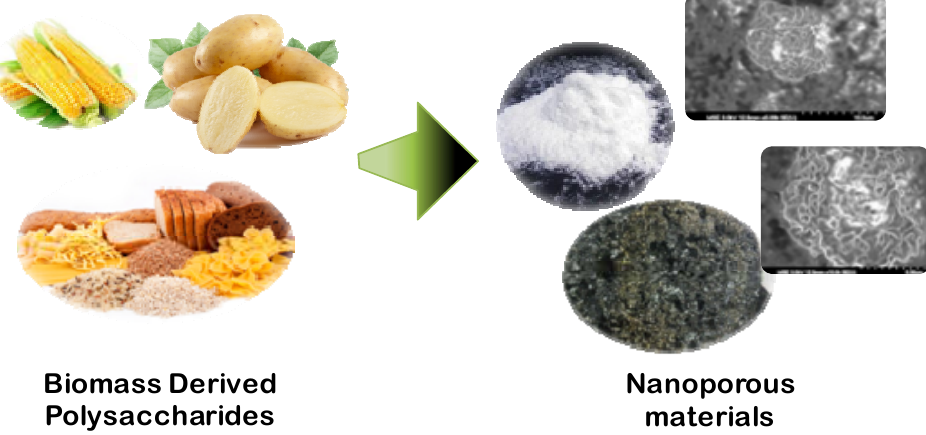
Figure 1. Overview of the research objective; transformation of non-porous native polysaccharide into useful porous carbonaceous materials. Adapted from